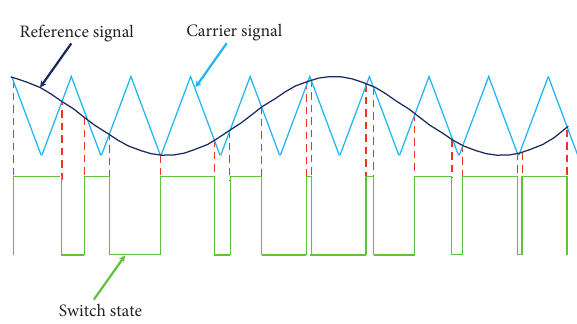
Figure 2: Pulse-width modulation